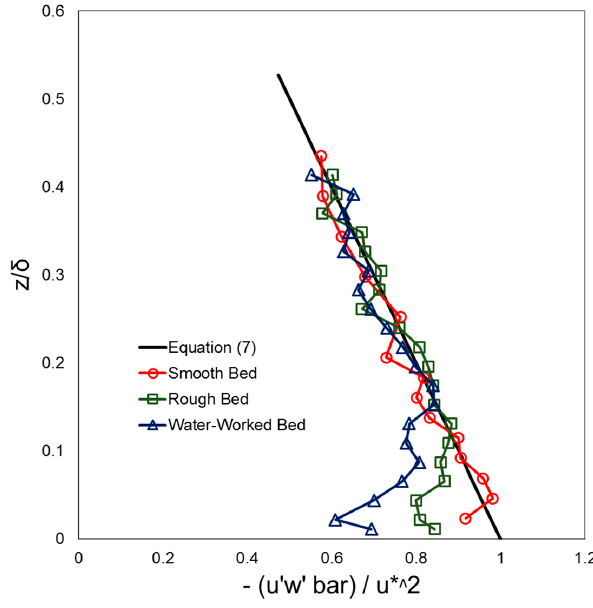
Figure 7. Measured normalised Reynolds stress profiles over smooth bed (Test 1), rough bed (Test 2), and water-worked bed (Test